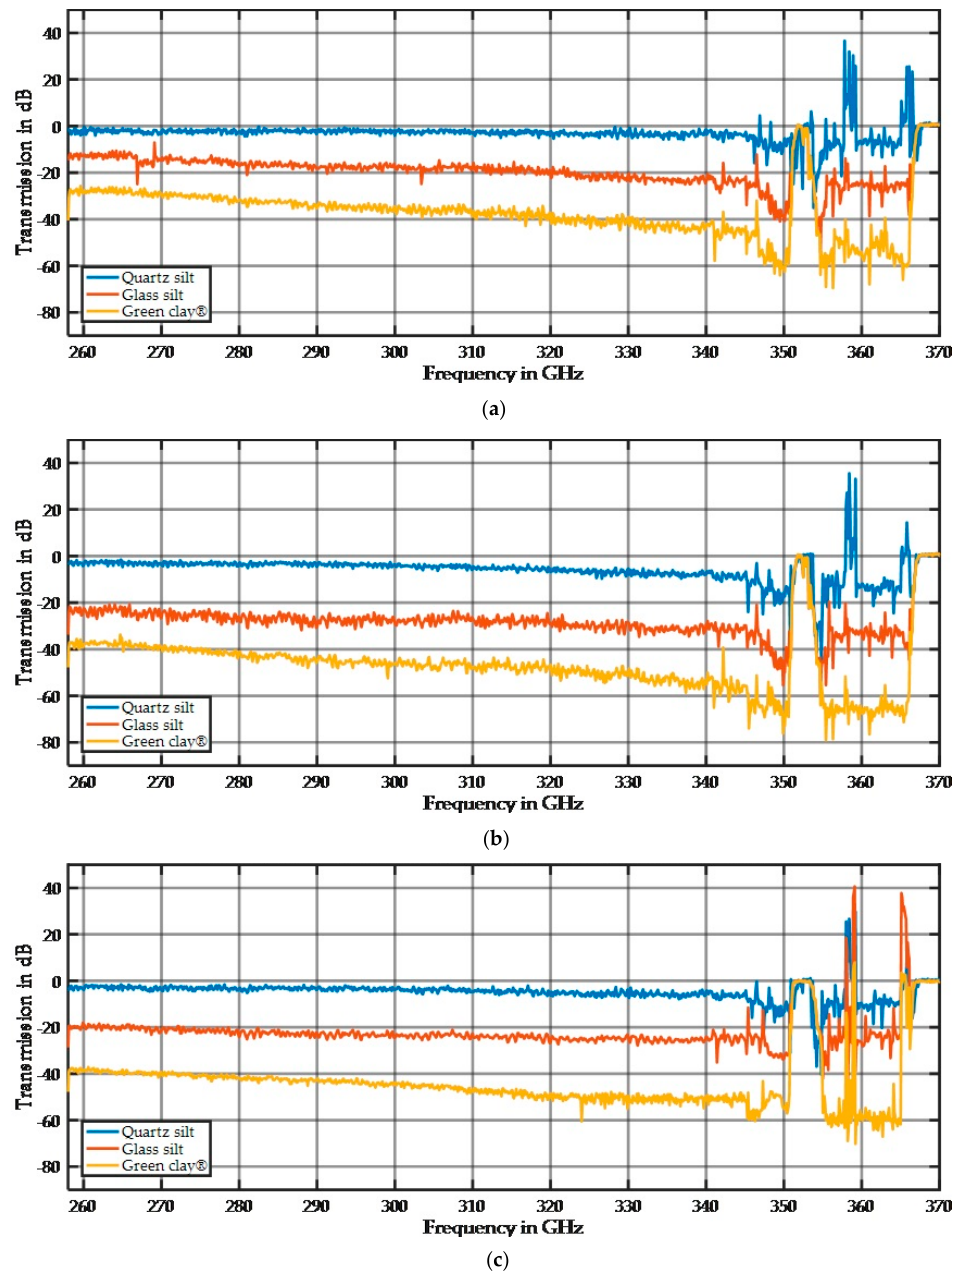
Figure 20. Measurement of quartz silt (45–63 µ m), glass silt (<50 µ m), and green clay (<2 µ m) at three different thicknesses: ( a ) 11 mm; ( b ) 14 mm; and ( c ) 17